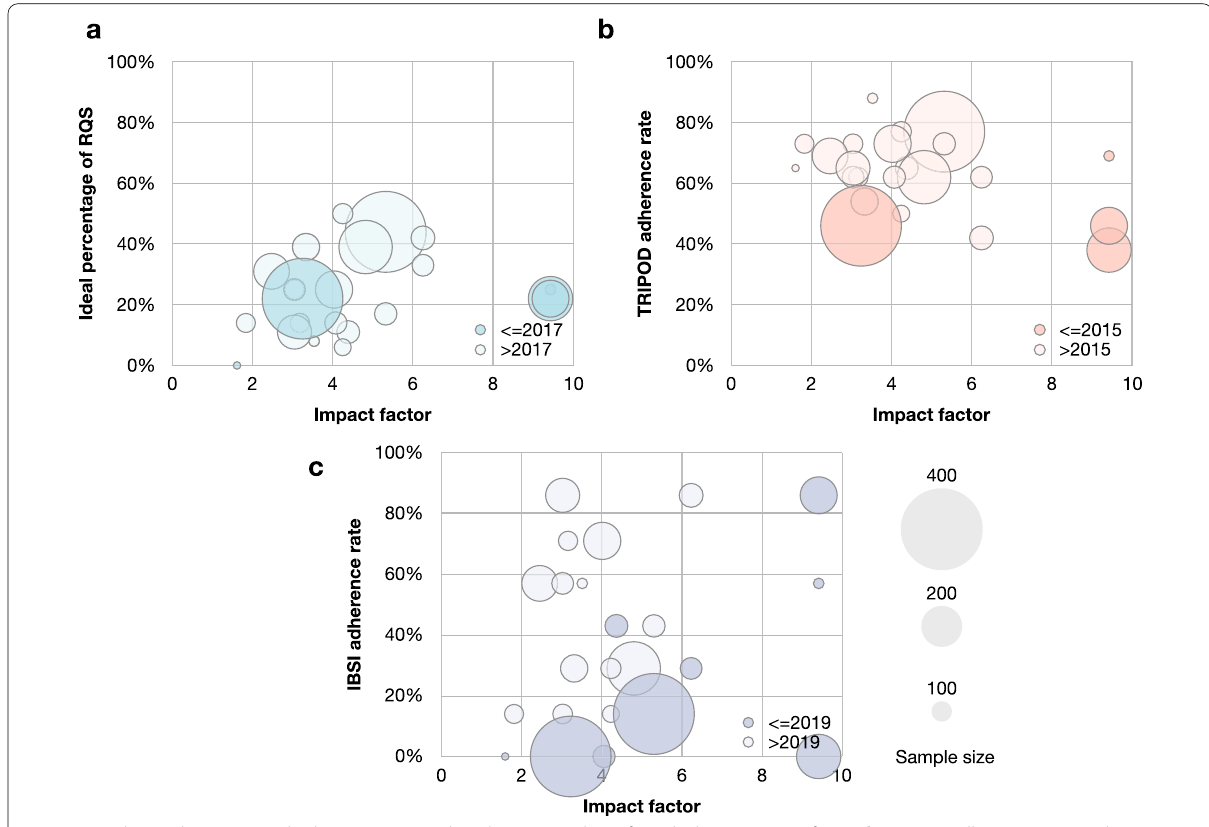
Fig. 6 Correlations between study characteristics and quality. Swam plots of ( a ) ideal percentage of RQS, ( b ) TRIPOD adherence rate, and ( c ) IBSI adherence rate. The diameter of bubbles indicates the sample size of studies. Seven studies published on journals without impact factor were excluded. The lighter color indicates the studies after the publication of RQS, TRIPOD, and IBSI; the darker color indicates those before their